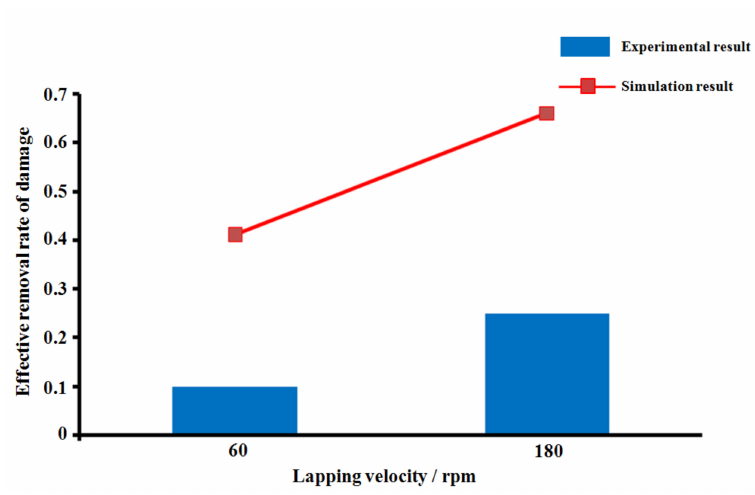
Figure 8. Result of ERRD under di ff erent lapping velocity.